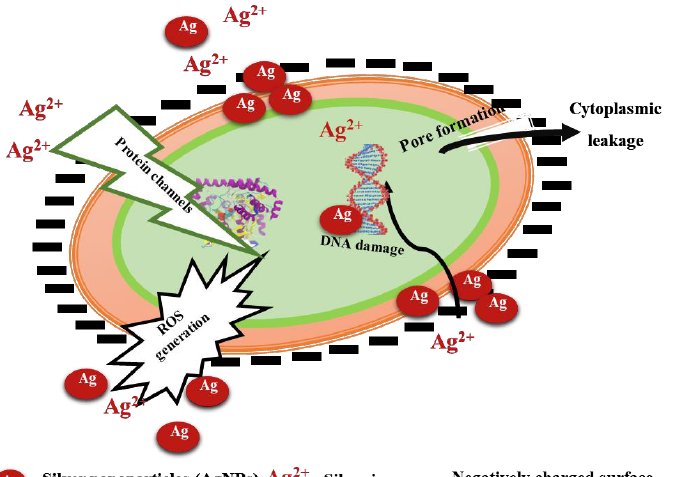
Figure 6. Mechanism involved in the bactericidal activity of silver nanoparticles (AgNPs) due to its nano and ionic attributes. DNA — deoxyribonucleic acid and ROS — reactive oxygen species